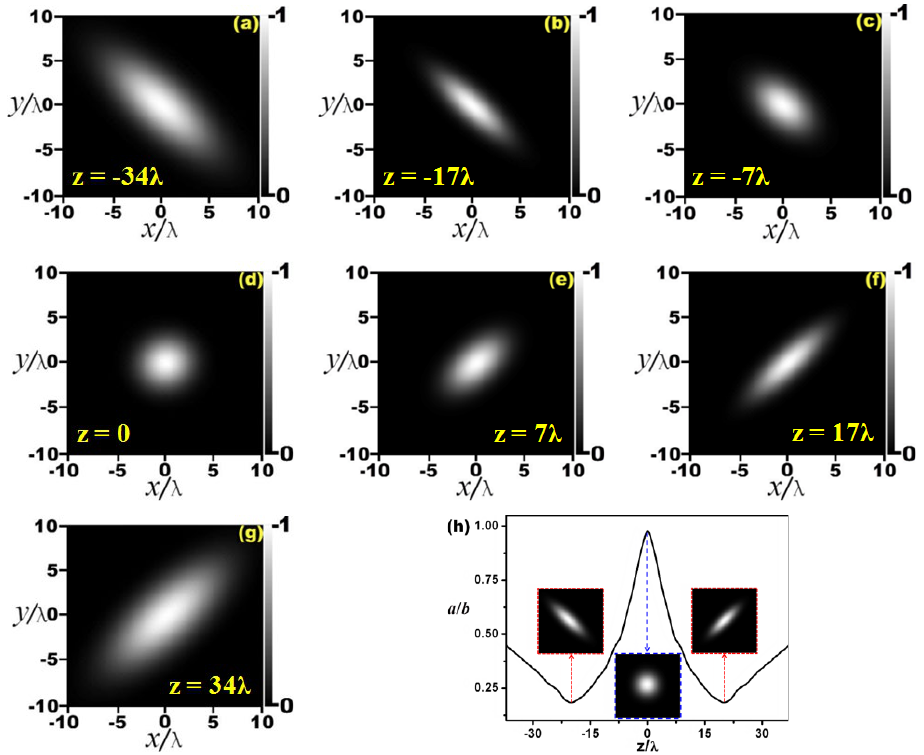
Figure 4. Intensity distributions in different cross sections around the focus, ( a ) z = − 34 λ , ( b ) z = − 17 λ , ( c ) z = − 7 λ , ( d ) z = 0, ( e ) z = 7 λ , ( f ) z = 17 λ , and ( g ) z = 34 λ ; ( h ) the ratio of the major radius to the minor radius of the elliptical beam profile versus its position in the optical axis. Parameters for calculation are chosen as λ = 633 nm, α = 3, NA = 0.9, f = 3.4 cm, µ = 10 mm − 2 , and E 0 =